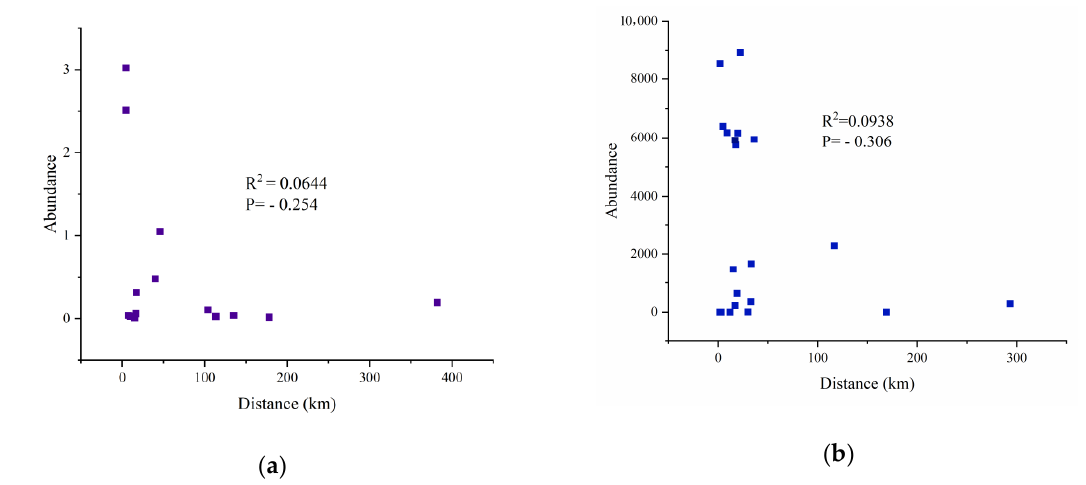
Figure 5. A scatter diagram of distance correlation between the concentration of microplastics in the waterbodies and the distance from the city center: ( a ) in developed countries; ( b ) in developing countries.